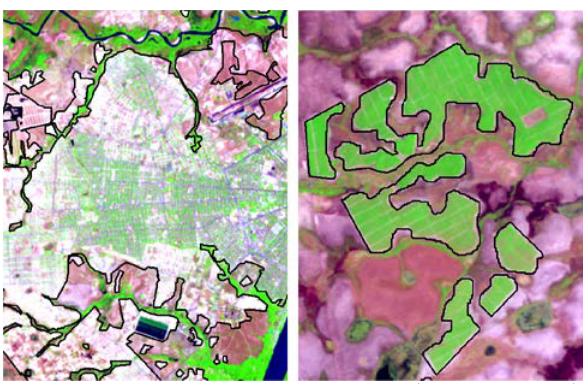
Figure 5 – Examples of urban area detection (image on the left), and agricultural areas (image on the right) at Boa Vista municipality in Roraima state, both revealing removal of non- forest